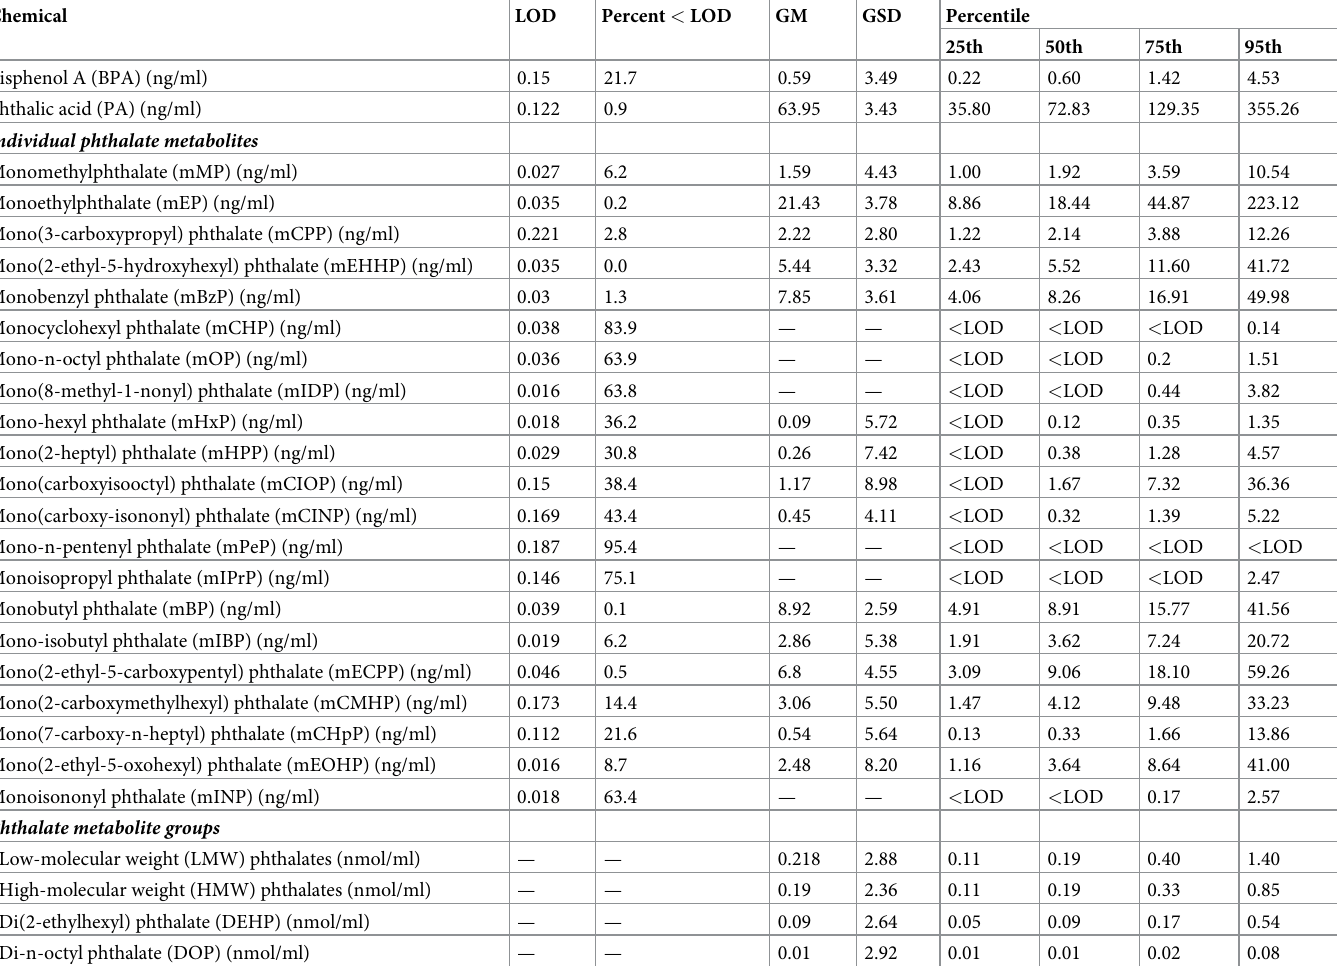
Table 2. Distributions of urinary BPA, PA, and phthalate metabolites collected over